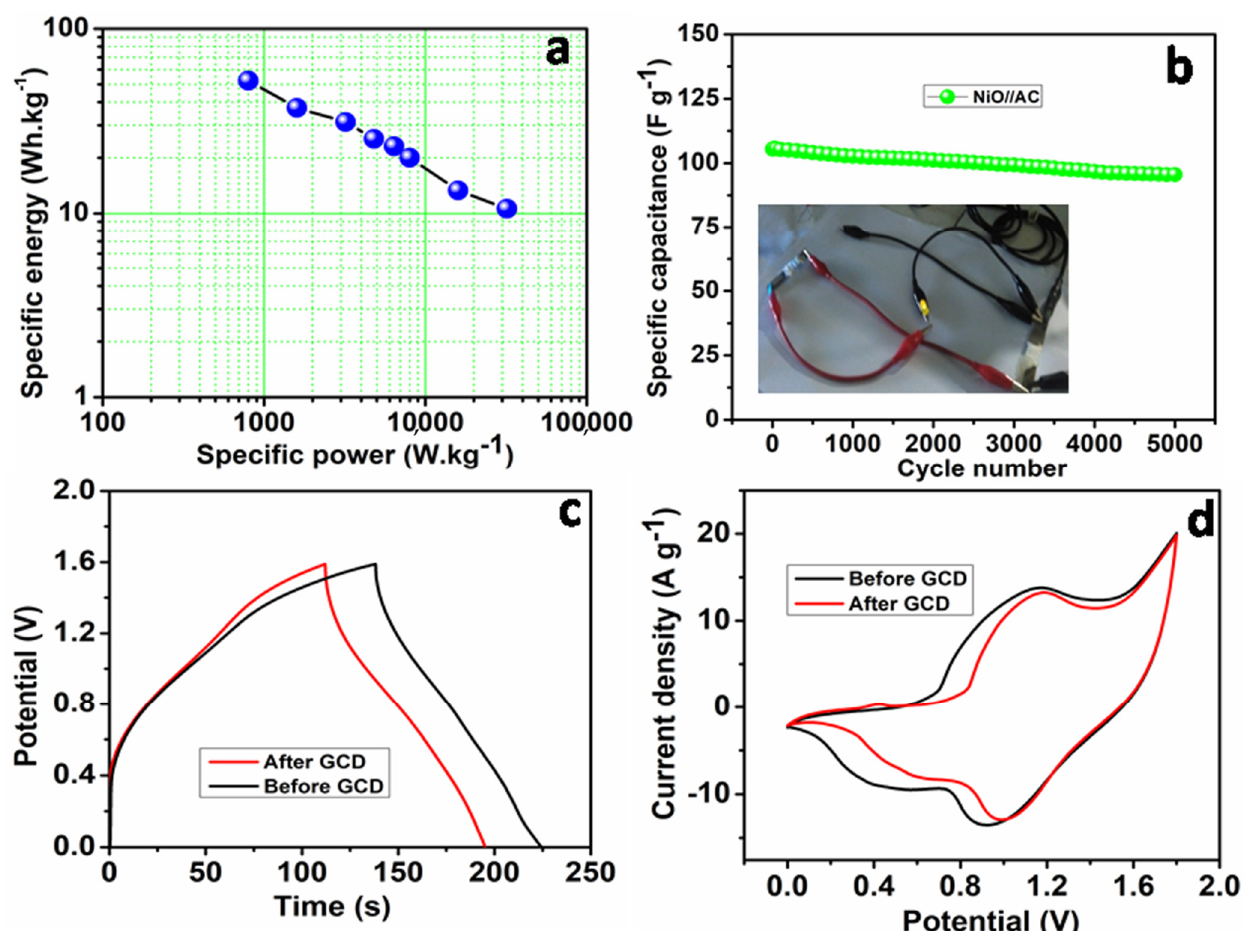
Figure 9. ( a ) Ragone plot of the assembled NiO//AC ASC device. ( b ) Long-term cyclability of the NiO//AC ASC device (Inset: Snapshot of light emitting diode powered by series of NiO//AC ASC devices). ( c ) GCD profiles of ASC device of before and after 5000 cycles. ( d ) CV curves of ASC device before and after the 5000th cycle of GCD measurements.